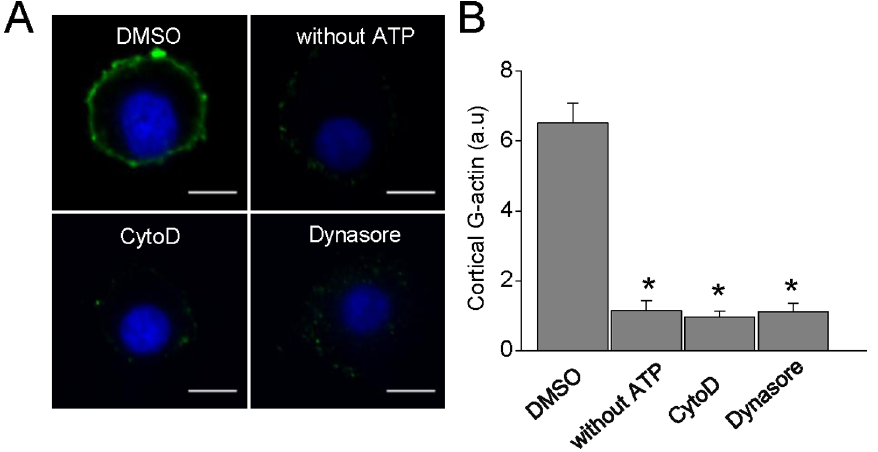
Figure 5. Inhibition of dynamin GTP-ase activity suppresses Ca 2 + -dependent denovo cortical actin polymerization. A: Representative images of F-actin formation in cells permeabilized in the presence of 10 m M free Ca 2 + . Note that no new polymerized cortical actin was observed when the permeabilization was performed in the absence of ATP-Mg (n=16) or in the presence of 4 m M CytoD (n=27) or 100 m M dynasore (n=28) Scale bar=10 m m B: Quantification of G-actin staining mean intensity at the cell periphery. Data are means of cortical actin fluorescence intensity *p , 0.05 compared with cells treated with DMSO (ANOVA).